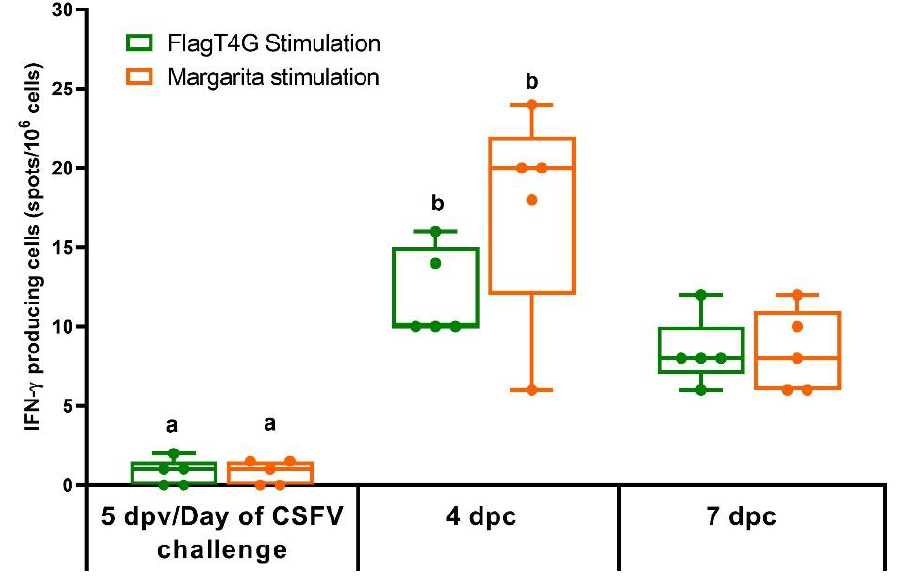
Figure 5. IFN- γ response in FlagT4G-vaccinated pigs. PBMCs from all the experimentally infected animals were stimulated by duplicate with the FlagT4G (green bars) and Margarita (Orange bars) viruses and evaluated by ELISPOT assay. Results are represented as the mean value of spots/10 6 cells for each stimulation at the respective time points. Unvaccinated and challenged animals remained unresponsive to either of the viral stimuli. Differences between a given sampling and the previous one within FlagT4G-vaccinated pigs (Friedman test) are represented by different letters ( p < 0.05). The phenotypical profile of PBMCs, evaluated by flow cytometry showed a higher proportion of CD8 + cells in the vaccinated animals at the time of the CSFV challenge (5 dpv), while the unvaccinated pigs had slightly higher CD4 + cells and CD172 + cell subsets.